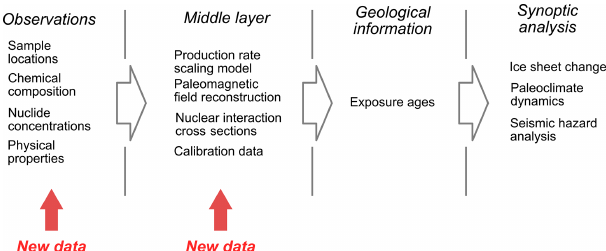
Figure 1. Conceptual workflow for applications of cosmogenic- nuclide exposure dating (or, in principle, nearly any other field of geochronology). Any large-scale analysis of ages or process rates needs to continually assimilate a growing observational data set and improving middle-layer calculations or else it will be immediately